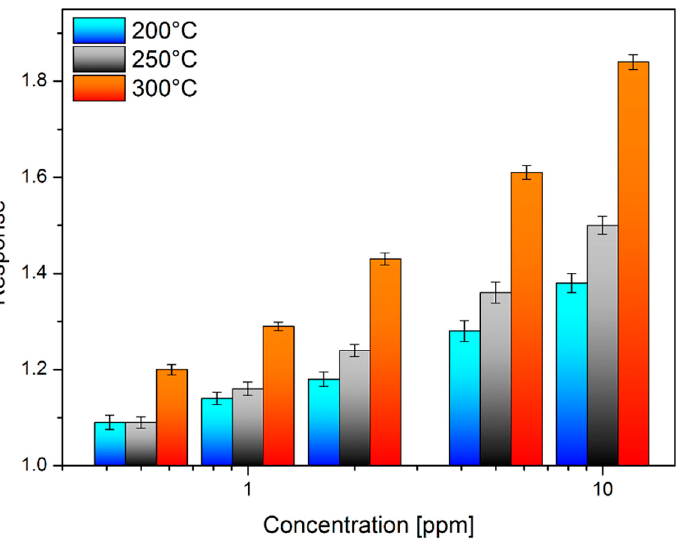
Figure 4. Sensor response as a function of ammonia concentration at three working temperatures.